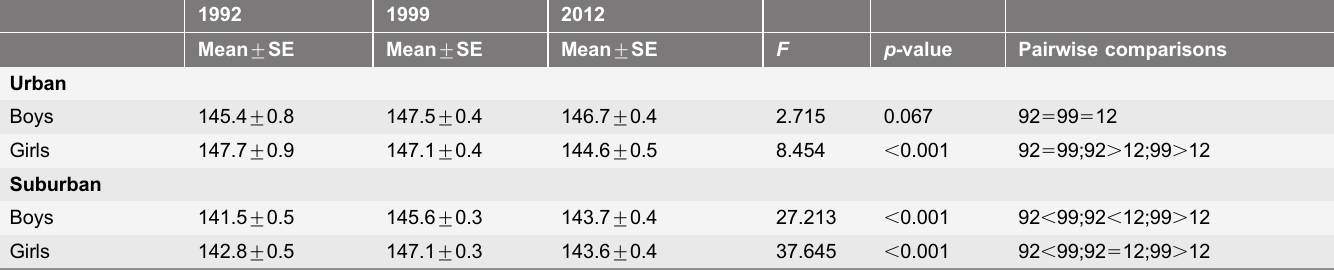
Table 6. Age and biological maturation-adjusted means ¡ standard errors of boys and girls heights according to study year and region.